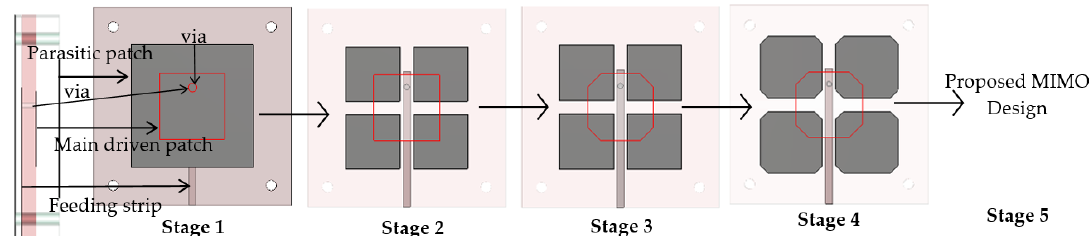
Figure 4. Evolution design procedure of the proposed antenna from Stage 1 to Stage 5.